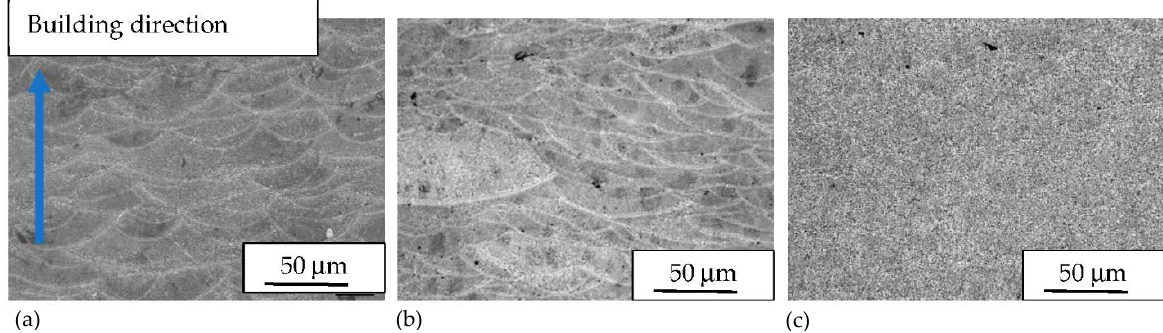
Figure 1. Optical images of AlSi10Mg after etching of ( a ) UT, ( b ) 2h-300 and ( c ) 2h-400 specimens. (The images are referred to the direction parallel to the building direction — XZ).